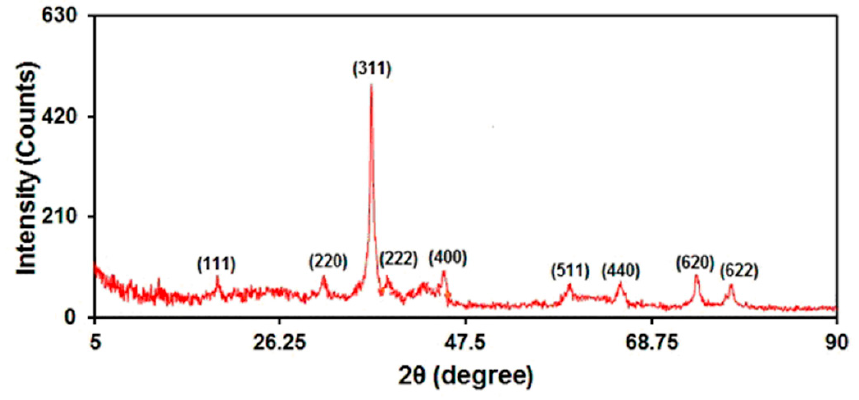
Figure 4. XRD pattern of graphene-Co 3 O 4 nanocomposite.